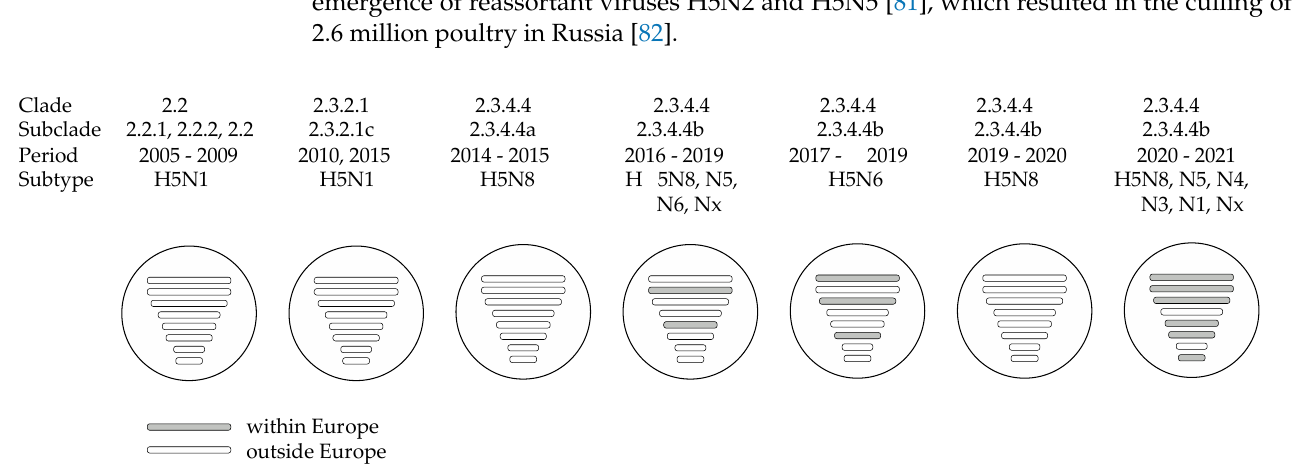
Figure 2. Highly pathogenic avian influenza H5 GsGd virus incursions into Europe (2005–2020) were associated with abundant reassortment with Asian and European low pathogenic avian influenza viruses. Multiple different clade 2.3.4.4b assortments circulated with some variants containing genomic segments derived from low pathogenic avian influenza viruses circulating in wild birds in Europe, suggesting reassortment upon introduction into Europe. Please note that inference of reassortment location is heavily biased by the intensity of influenza surveillance and the availability of virus genome sequences. References used [35,55,76].